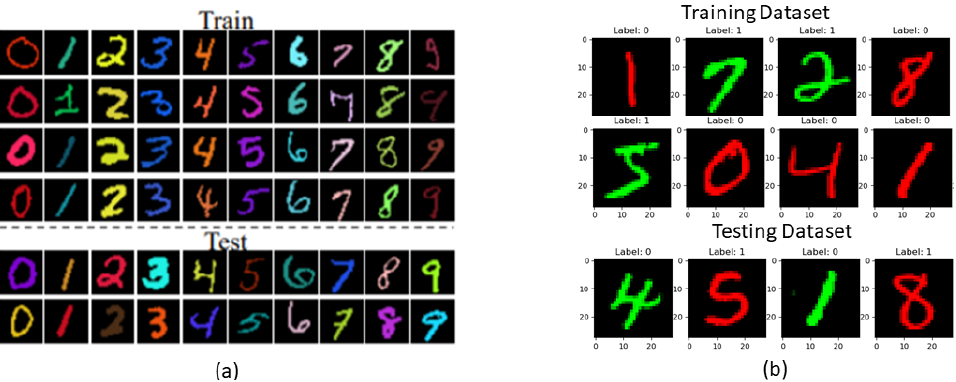
Figure 3. Colored MNIST Training and Testing Datasets Examples with color bias: ( a ) Some image examples of color-biased MNIST dataset - Modified MNIST dataset with a color bias for each digit. Taken from [6] ( b ) Some image examples of reversed color-biased MNIST dataset—Binary group based color bias prepared for IRM